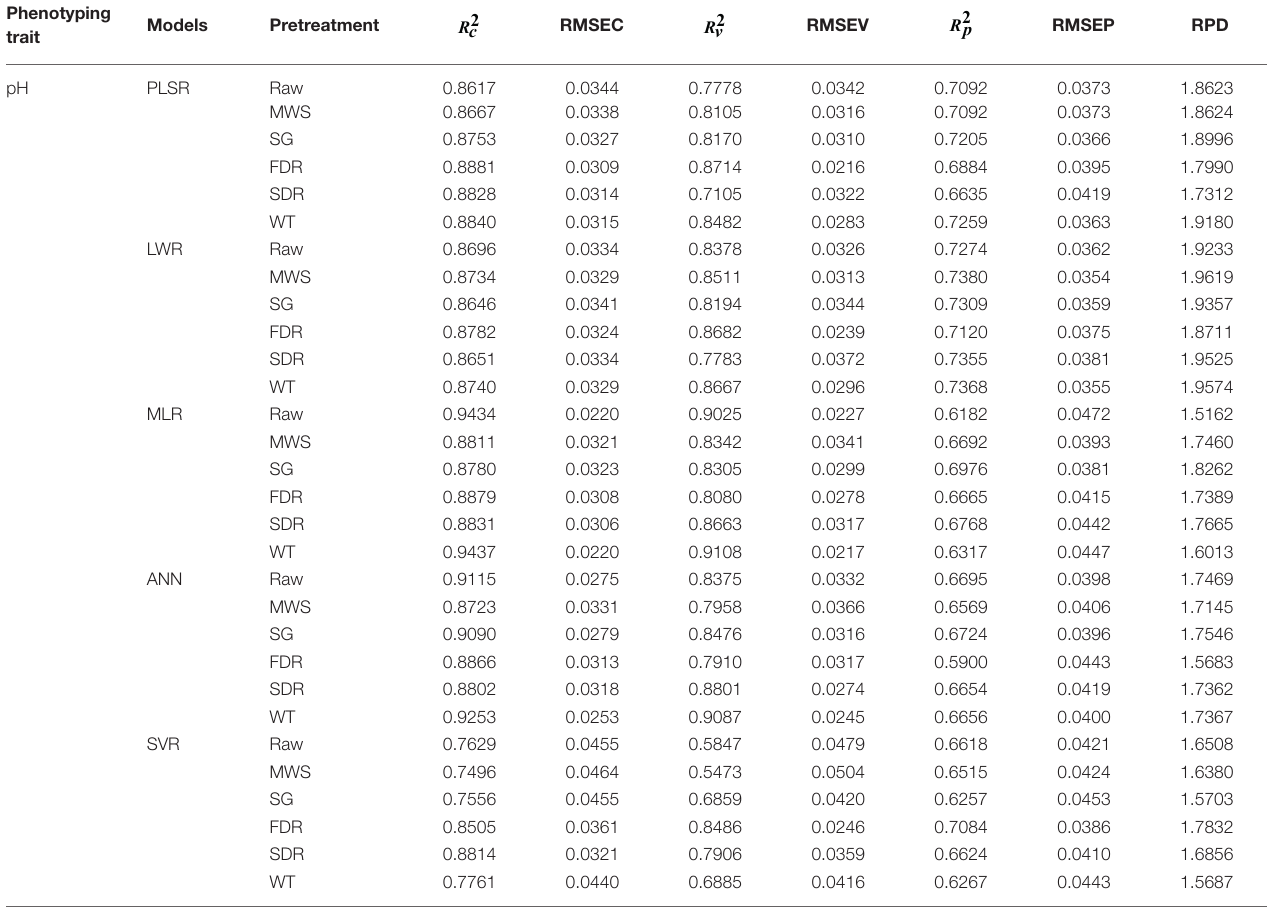
TABLE 4 | Prediction of the pH of lettuces based on various multivariate analysis methods. Phenotyping Models trait